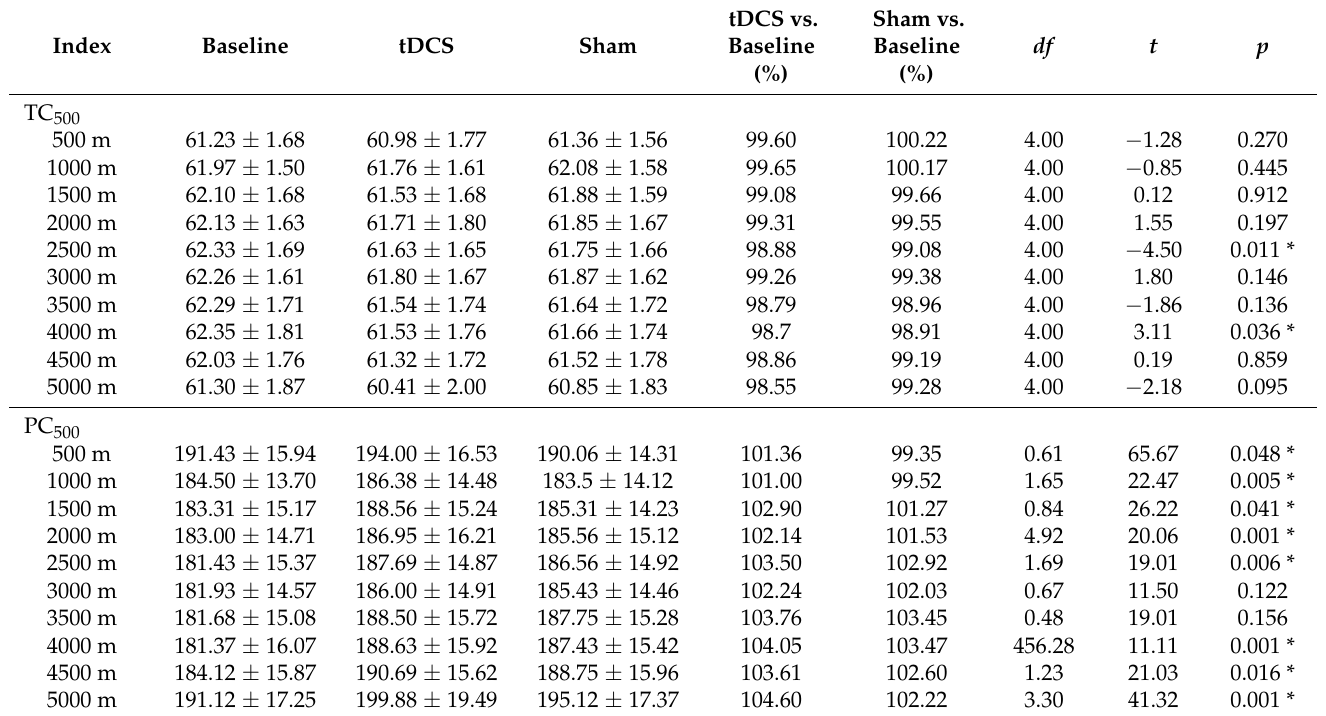
Table 2. Effect of transcranial direct current stimulation (tDCS) on time corresponding to 500 m (TC500) and power corresponding to 500 m (PC500) during 5 km row (data are presented as mean ± SD; n =